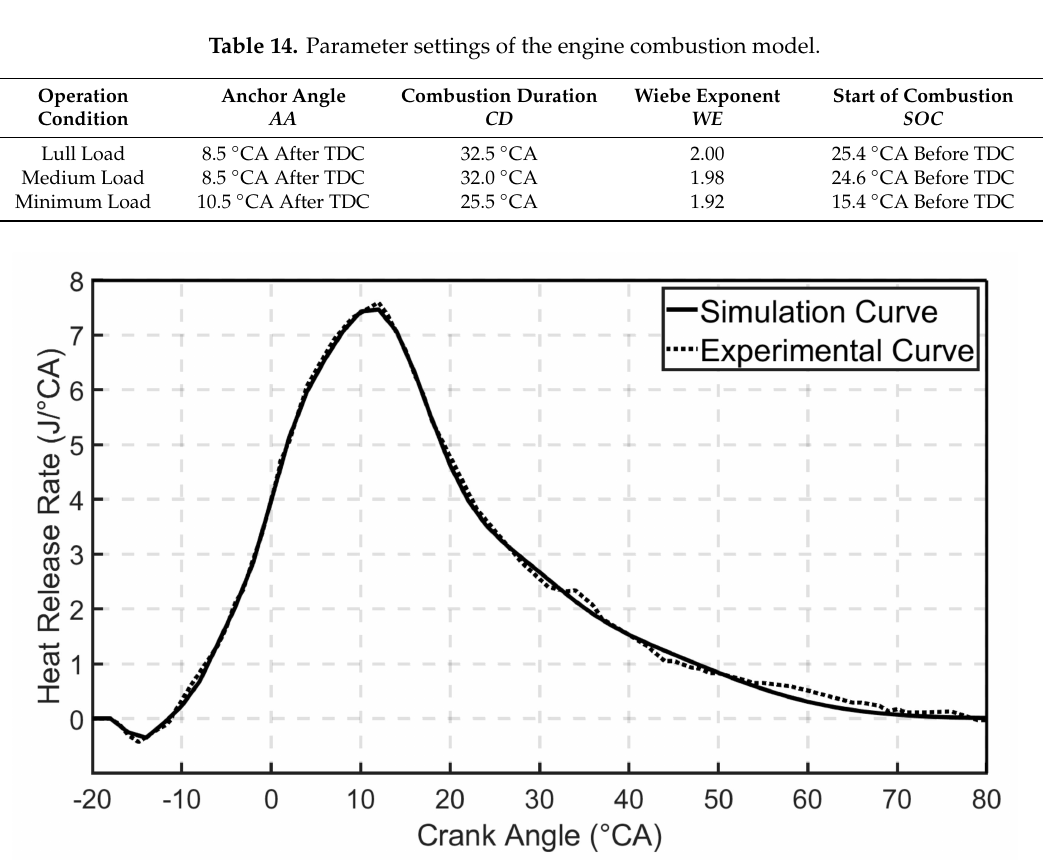
Figure 22. Comparison between heat release curves (minimum